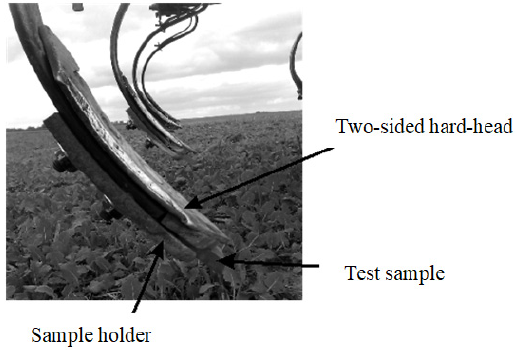
Figure 2. A view of test sample before field testing.